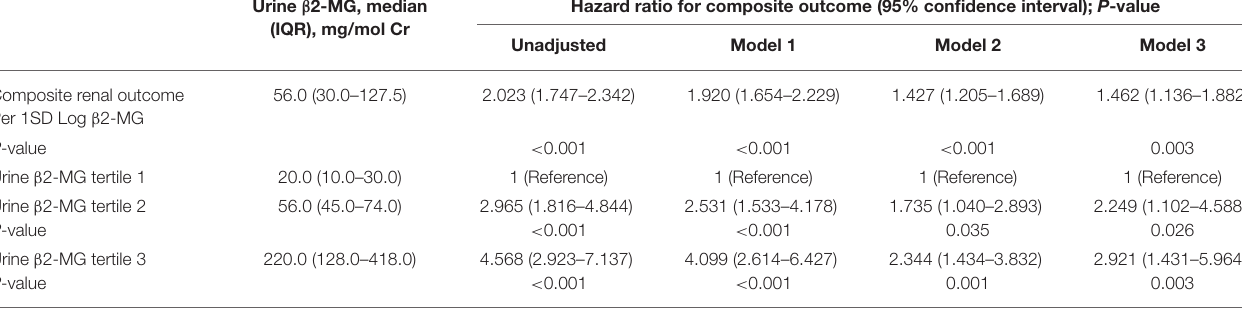
TABLE 2 | Association of baseline urinary β 2-MG levels with the composite renal outcome. Urine β 2-MG, median Hazard ratio for composite outcome (95% confidence interval); P -value (IQR), mg/mol Cr Unadjusted Model 1 Model 2 Model 3 Composite renal outcome Per 1SD Log β